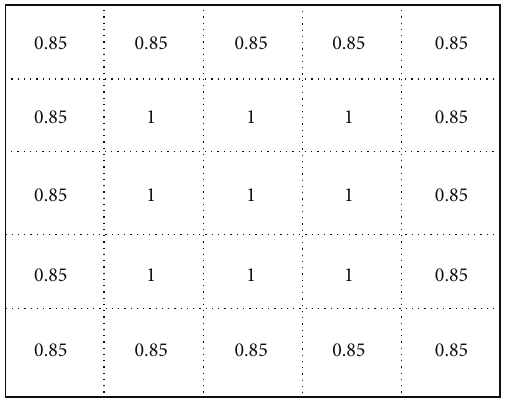
Figure 5: Radial power distribution A.